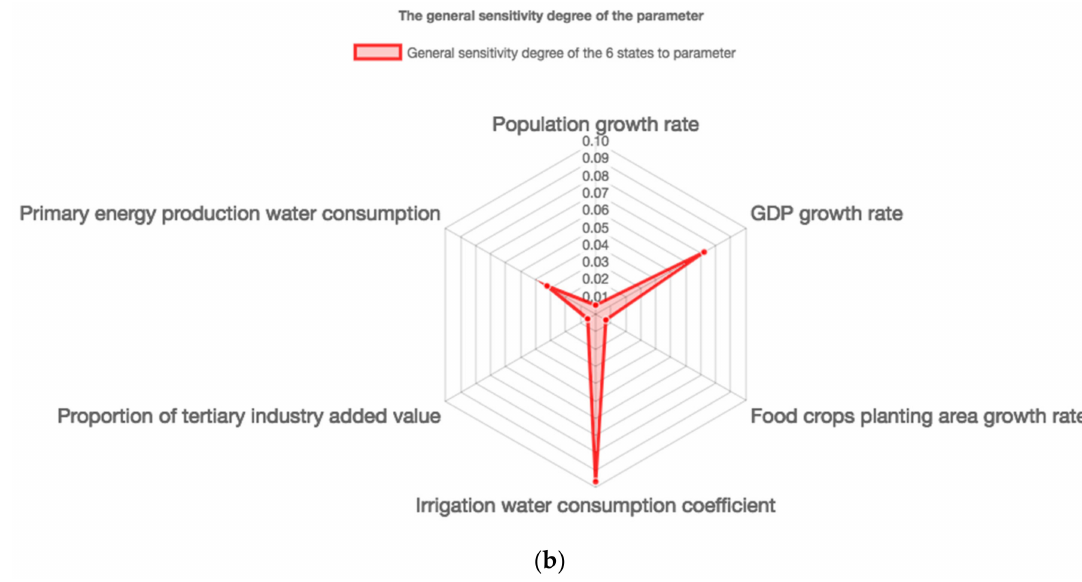
Figure 7. Sensitivity degree analyses result: ( a ) The sensitivity degree of each state variable to each parameter; ( b ) The general sensitivity degree of the parameter.